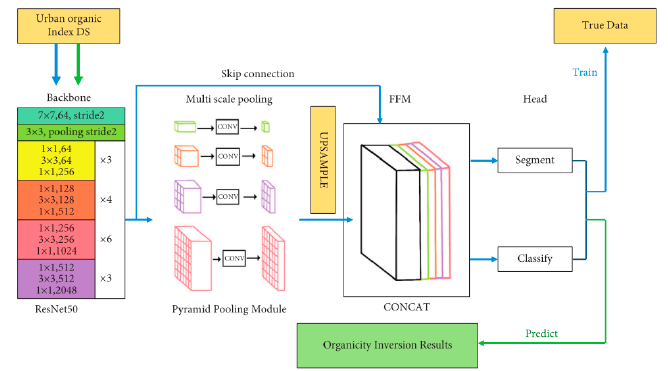
Figure 5. Convolution Neural Network Judgment Model.